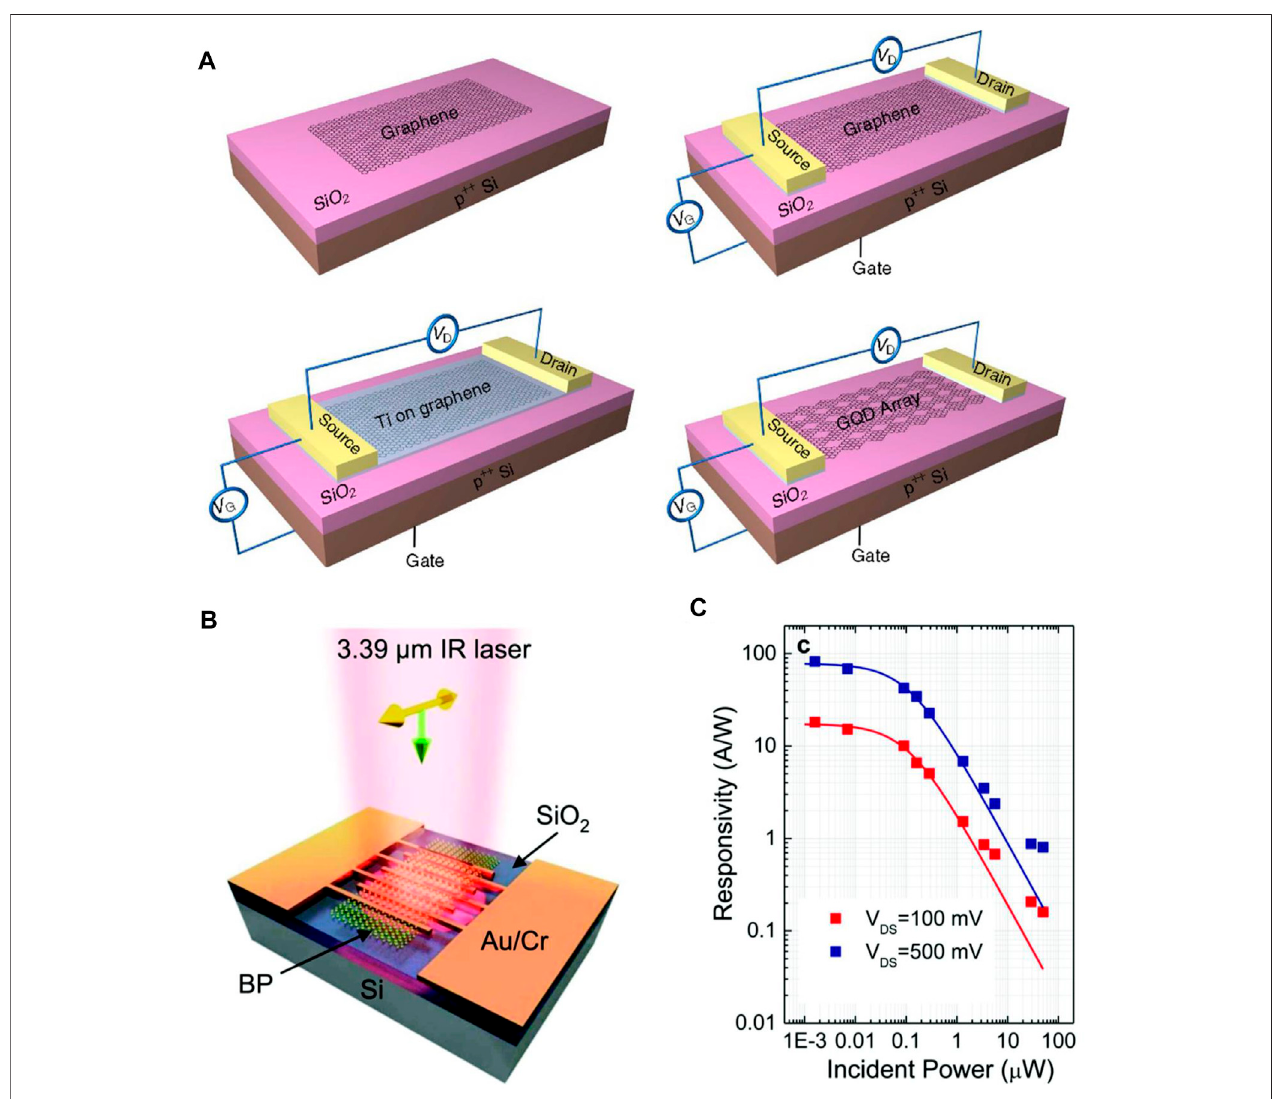
FIGURE 17 | (A) Fabrication process of graphene-based photodetector band engineering (Zhang et al., 2013b), (B) Schematic of BP based photodetectors, and (C) BP based photodetector responsivity (Guo et al., 2016); Reproduced with permission from (Zhang et al., 2013b; Guo et al., 2016).